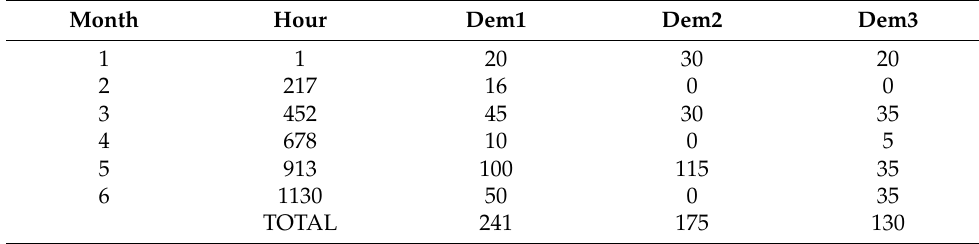
Table 5. Model Conditions